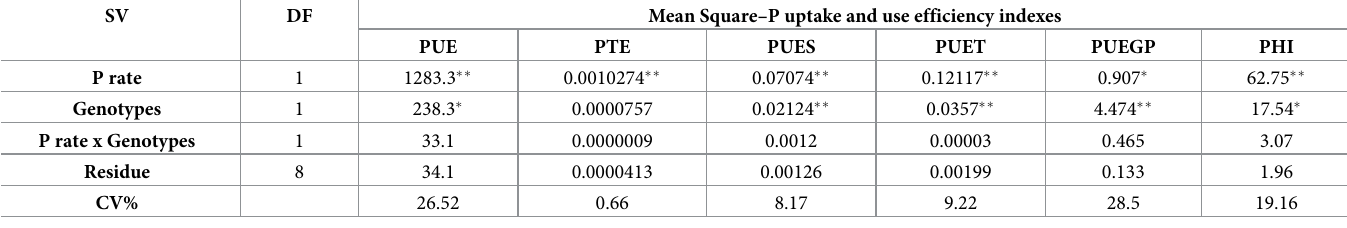
Table 4. Summary of analysis of variance in regard to the P uptake and use efficiency indexes of the IAC Imperador and DOR 364 common bean genotypes grown hydroponically under a restrictive phosphorus condition and under a control condition. SV DF P rate